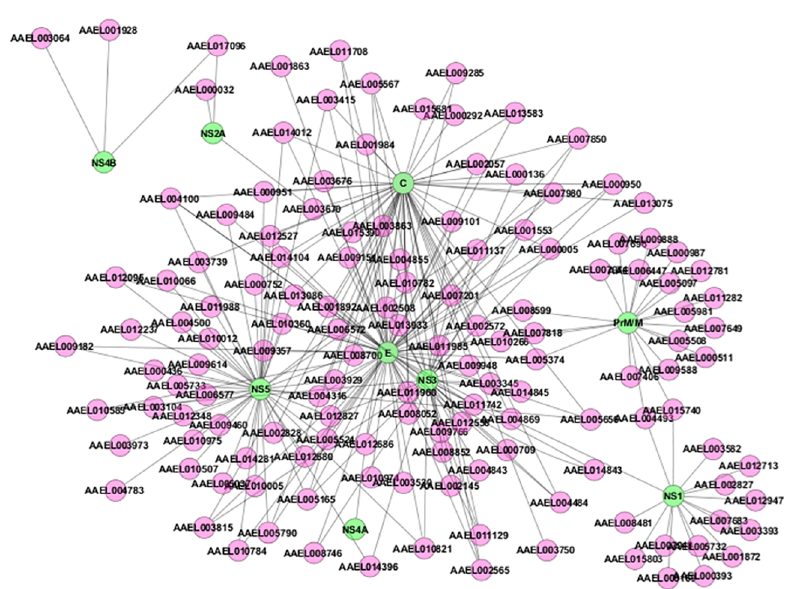
Fig 10. Dengue–mosquito PPI network. A complete set of dengue–mosquitoprotein interactionsidentified in this study isshown. Green ovals indicate dengueproteins, pink ovals indicate mosquitoproteins, and black lines indicate dengue–mosquito protein interactions. PPI, protein–protein